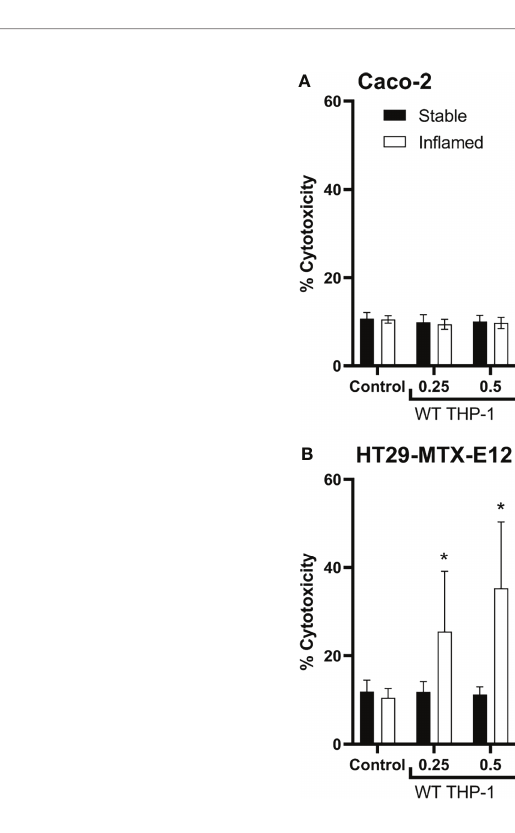
FIGURE 7 | Cytotoxicity in Caco-2 (A) or HT29-MTX-E12 (B) monocultures after treatment with basolateral supernatants ( = 48h; relative concentration 0.25, 0.5 or 1) from stable (full bars) or in fl amed (open bars) triple cultures (WT, CASP1 -/- or NLRP3 -/- THP-1 cells) for 48 (h) Cytotoxicity was assessed via LDH assay. Mean ± SD of N = 5, *p < 0.05 compared to the untreated